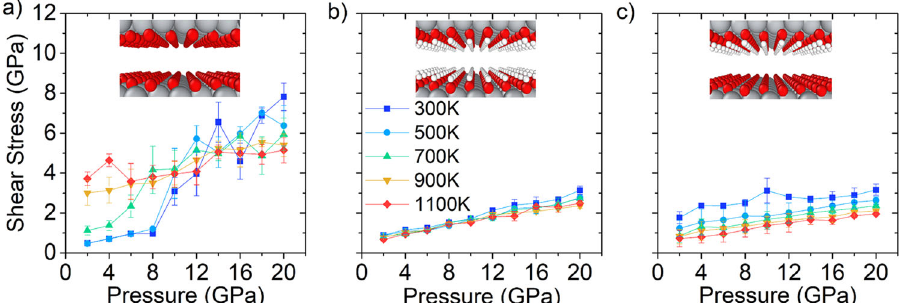
Fig. 1 MXene shear stresses. Shear stress of a O-terminated, b OH-terminated, and c heterostructure MXenes as a function of pressure at 300, 500, 700, 900, and 1100 K. The insets are close-up views of the model MXenes before they are thermalized and loaded. The error bars re fl ect the standard error of three sliding